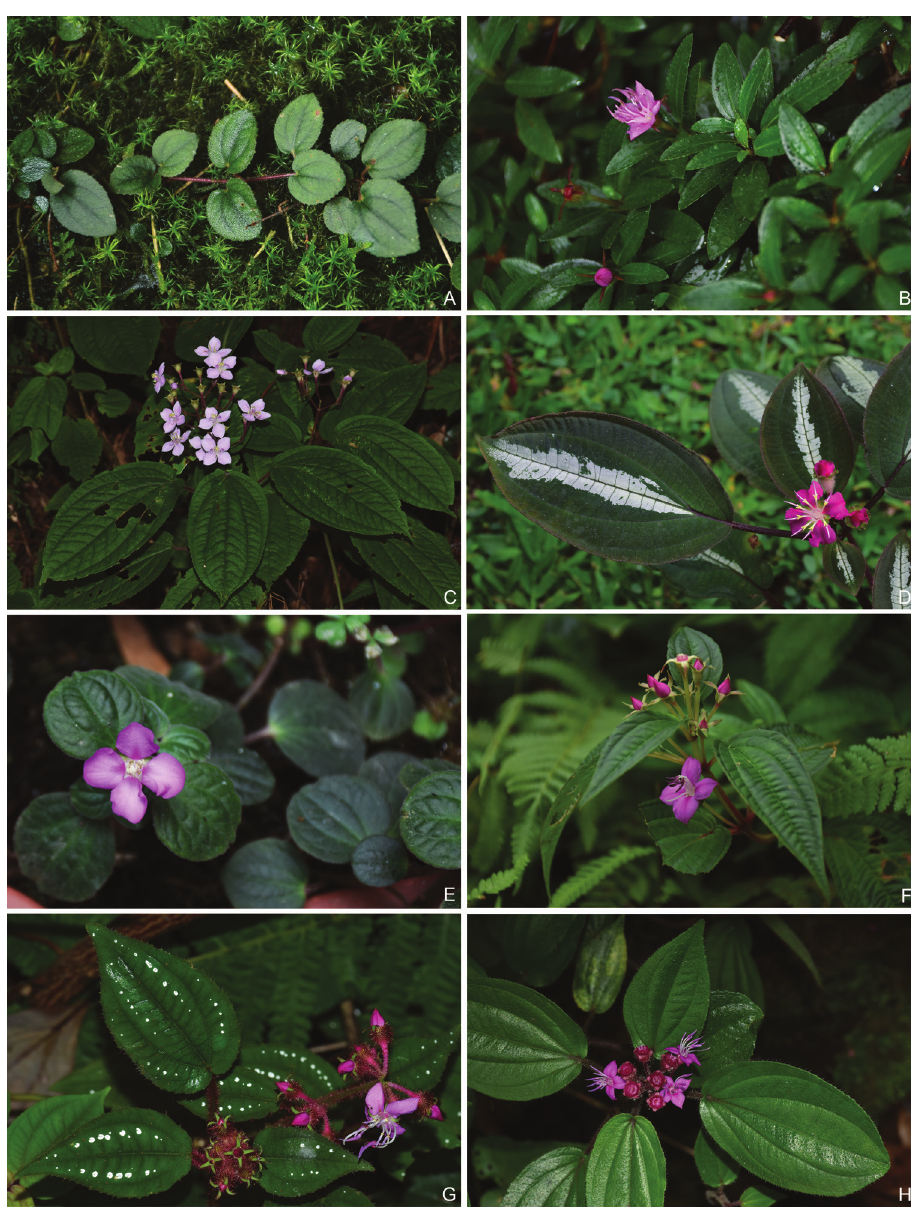
Figure 3. Leaf morphology of the Bredia clade. A B. changii ( Y. Liu 548 ) B B. guidongensis ( Y.